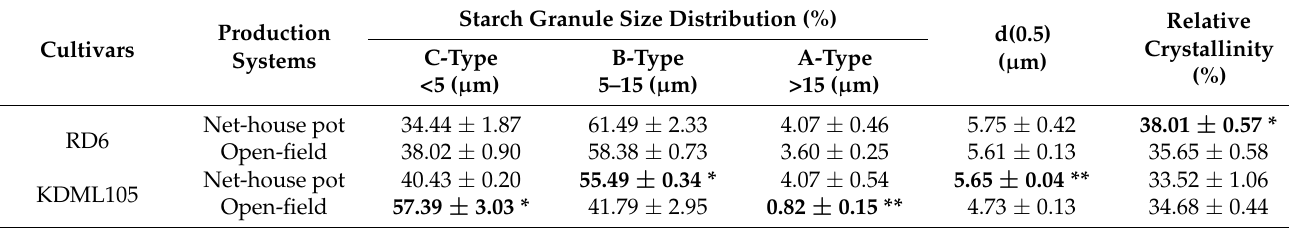
Values are means ± SEM. Means in bold within each column with the * and ** symbols denote statistically significant difference between the two production systems at p ≤ 0.05 and p ≤ 0.01, respectively, by Student’s t -test ( n = 3 for starch granule size distribution and median particle size analyses; n = 4 for relative crystallinity analysis). Abbreviations: d(0.5) = the granule size at which 50% of all the granules by volume are